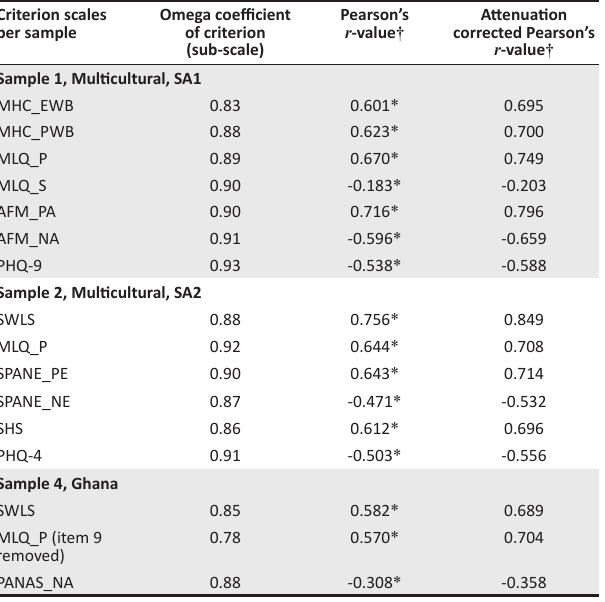
TABLE 5: Correlations between the Harmony in Life Scale and other measures of well-being and ill-being for Samples 1, 2 and 4. Criterion scales per sample